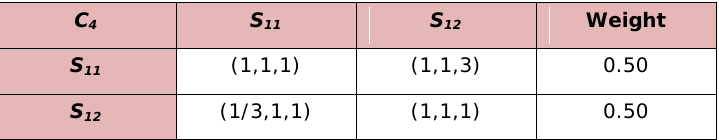
Table 6. “Fuzzy comparison matrix of the sub-criteria with respect to trust”.